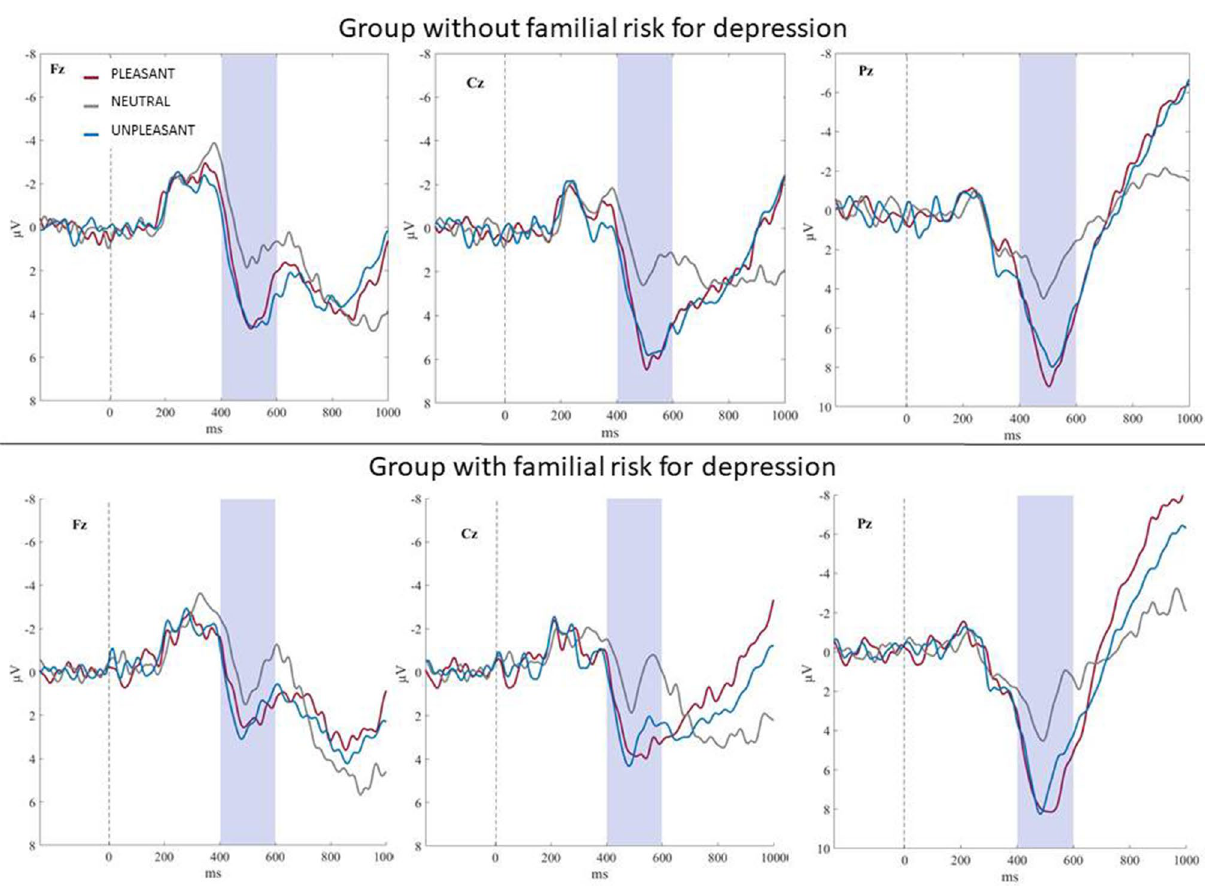
Figure 1. Grand-average ERP waveforms recorded at Fz, Cz, and Pz to pleasant, neutral, and unpleasant pictures in the group with and without familial risk for depression. The colored frame represents the 400– 600 ms time